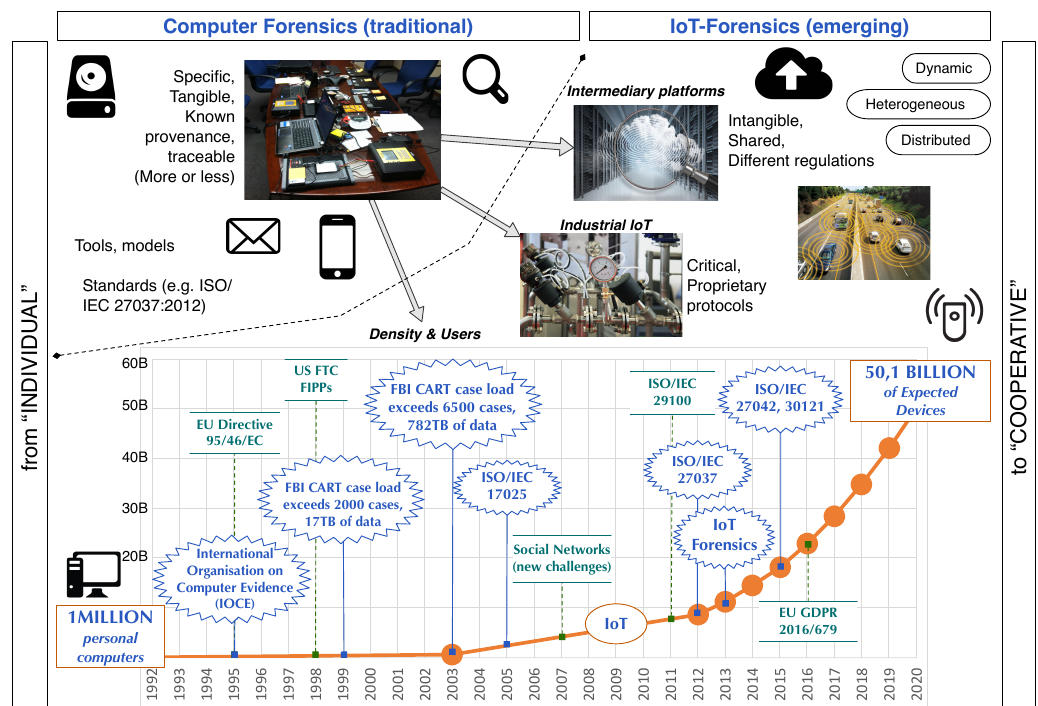
Figure 1. From computer forensics to